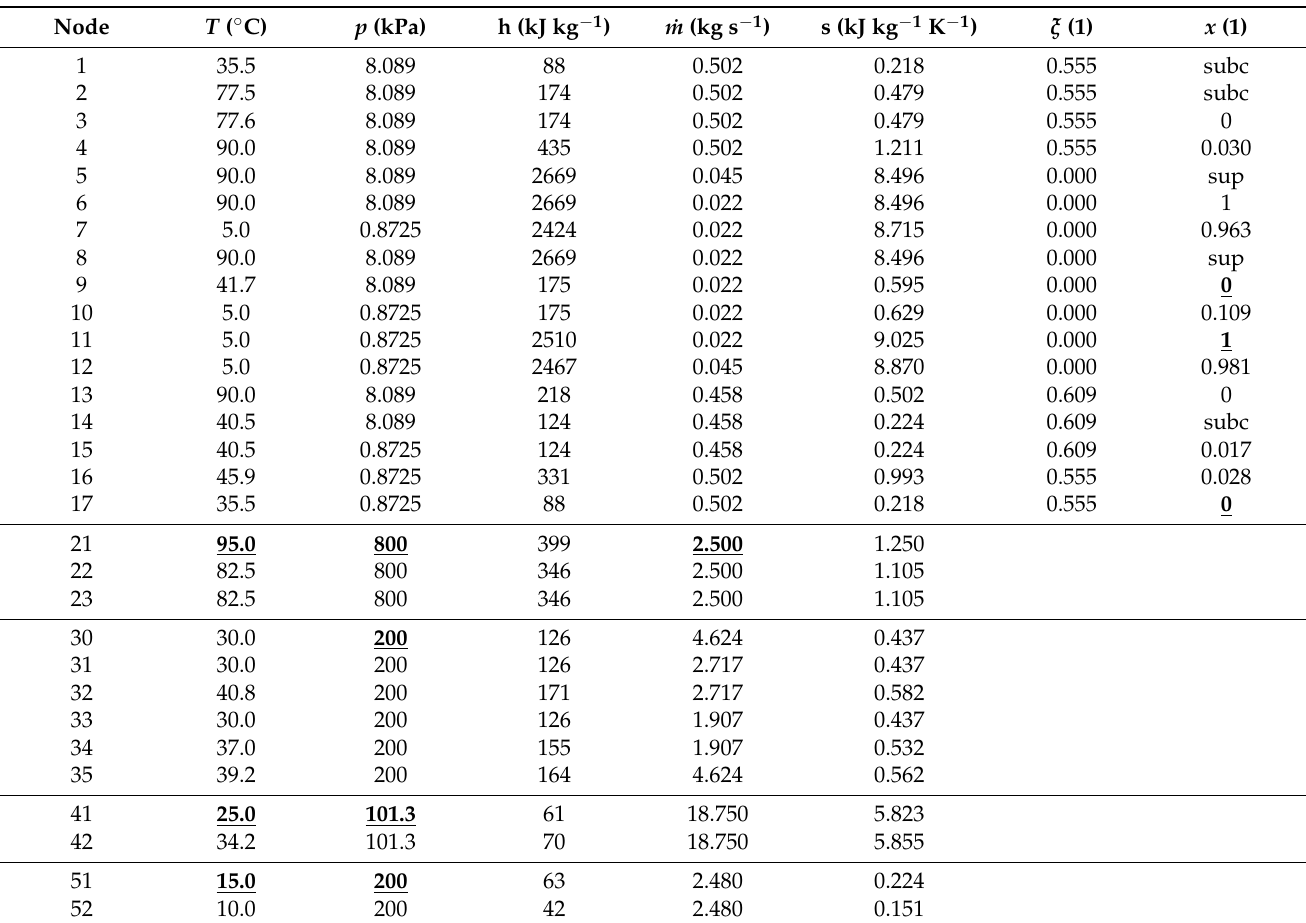
Table A3. Parameters of the APCC in its nodes after optimisation for heat source utilisation (imposed values in underscored